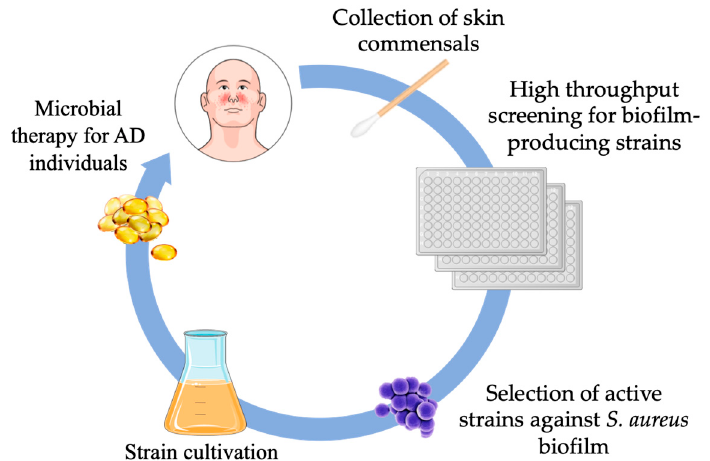
Figure 3. The exploitation of microbial dynamics in the skin may lead to new strategies for therapeutic interventions against pathogenic microbial biofilms. Initially, biofilm-producing skin commensal species isolated from AD individuals and capable of exerting an effective competition against S. aureus biofilm will be selected for expansion. The ideal strain(s) will be appropriately formulated for topical applications and administered to patients.